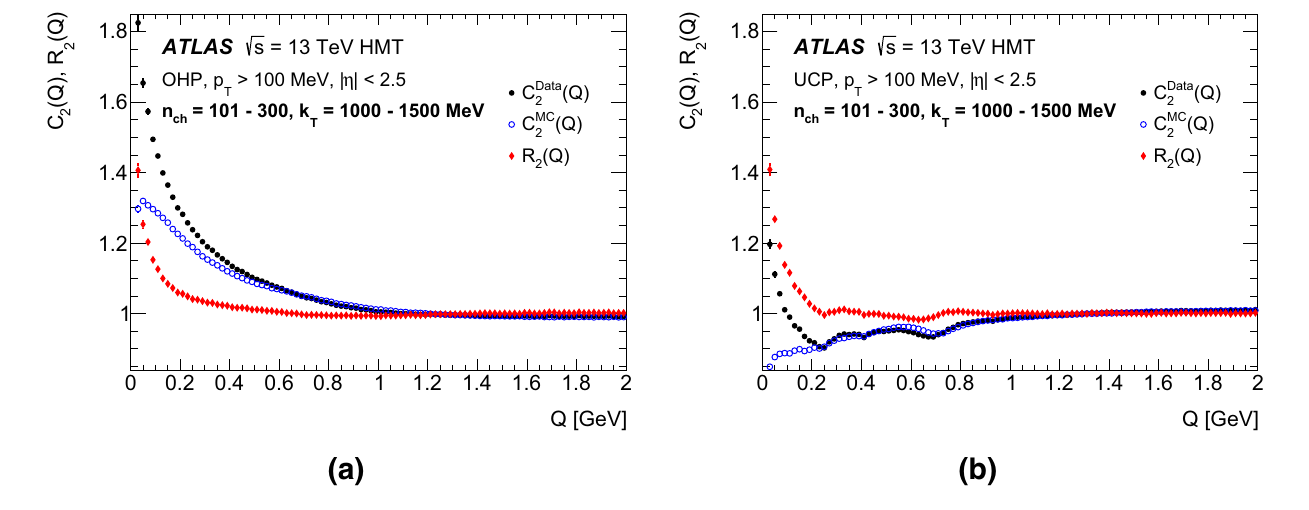
ence sample for k T -interval 1000 < k T ≤ 1500 MeV and b the unlike-charge particle (UCP) pairs reference sample for k T -interval 1000 < k T ≤ 1500